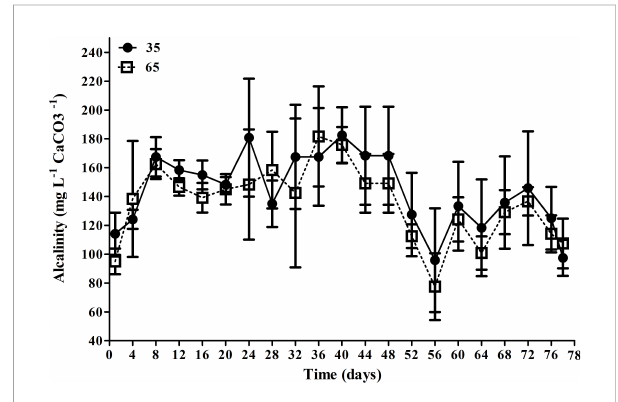
FIGURE 1 Mean alkalinity concentrations (mg L -1 of CaCO3) in the T35 and T65 treatments over the 78 day experimental period. Data are presented as mean ± standard